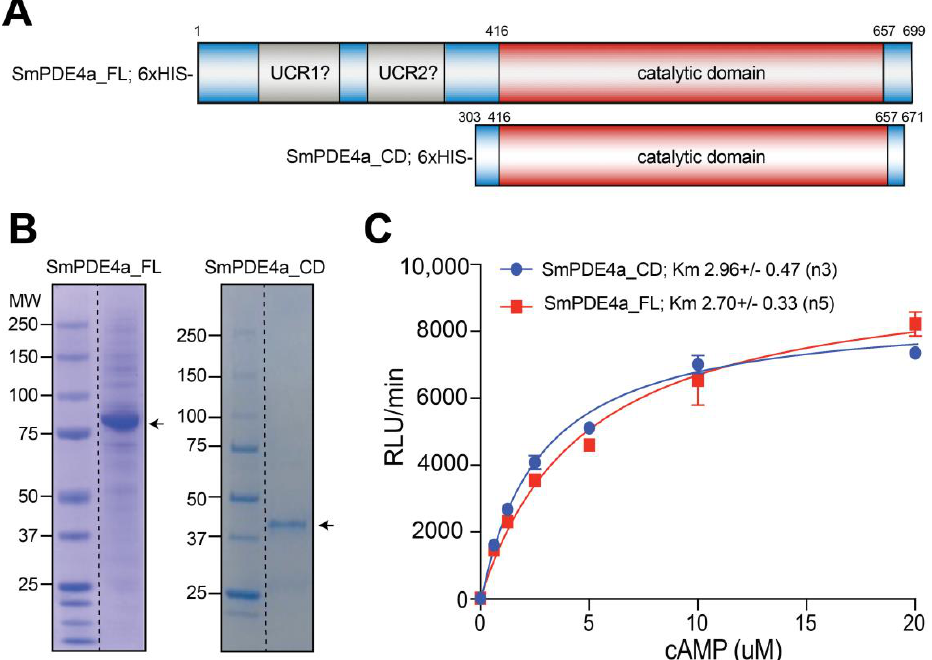
Figure 1. Expression and functional comparison of SmPDE4a_FL and SmPDE4a_CD. ( A ) Schematic view of the constructs for SmPDE4a _FL (amino acids 1–699) and SmPDE4a _CD (amino acids 303–671) with a 6×His tag on the N -terminus. The SmPDE4A_FL protein contains next to the catalytic domain (amino acids 416–657 in the red box) two potential regulatory UCR domains (gray boxes). ( B ) SDS-PAGE analysis of the purified SmPDE4A_FL and SmPDE4A_CD (indicated with an arrow) with expected molecular weights of 80.0 and 42.3 kDa, respectively. ( C ) Michaelis–Menten kinetics, as analyzed with GraphPad Prism, version 8, of both SmPDE4A enzyme constructs at 10 nM and 11 nM for, respectively, SmPDE4A_FL and